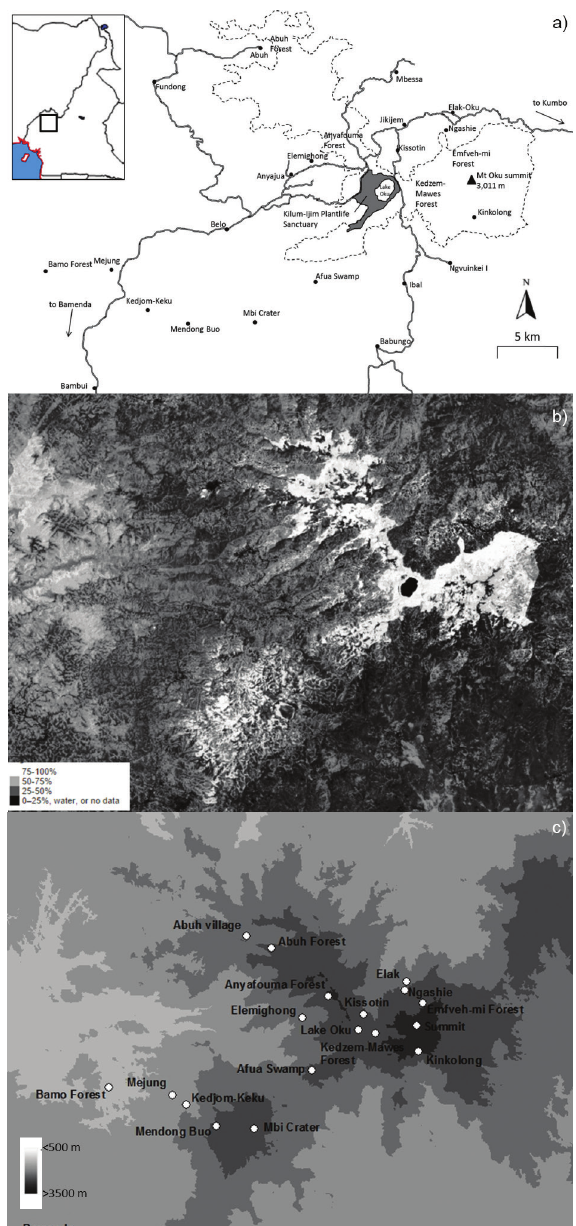
Figure 1. Maps: a Main localities on Mt. Oku and surrounding areas (= Oku Massif), including those sampled for amphibians. Dashed line indicates the boundary of the Kilum-Ijim Forest. The grey shaded area shows the Kilum-Ijim Plantlife Sanctuary government protected area. Road (solid lines) bisecting the Kilum-Ijim forest (dashed line) and larger urban centres (Belo, Fundong, Ibal) are also shown b forest cover indicated by white shading, from Hansen et al . (2013) (downloaded from https://earthenginepart- ners.appspot.com/science-2013-global-forest) c topographic map showing